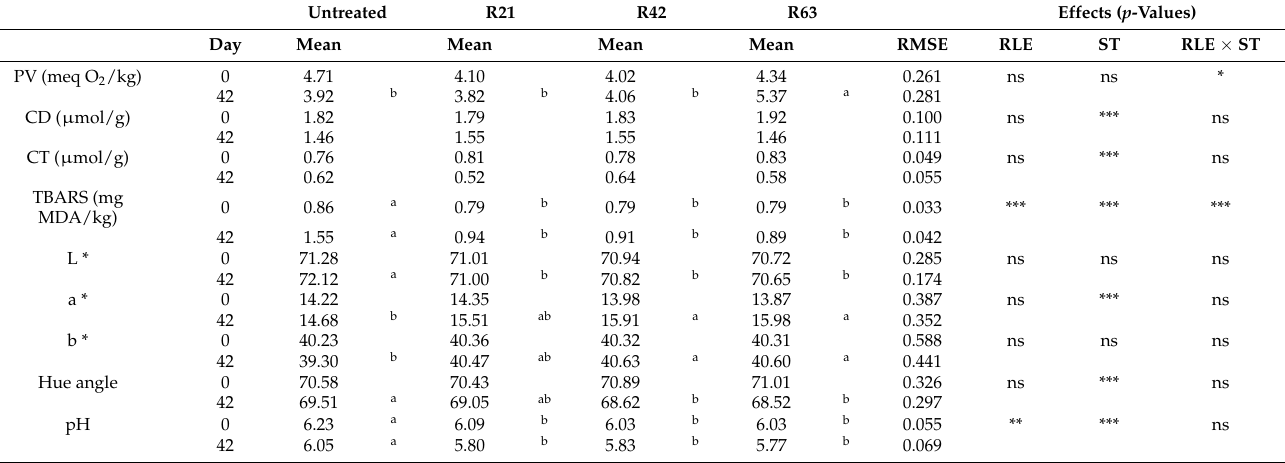
Table 4. Lipid oxidation indexes, CIELab colour (CIELab units) and pH of salmon p â t é